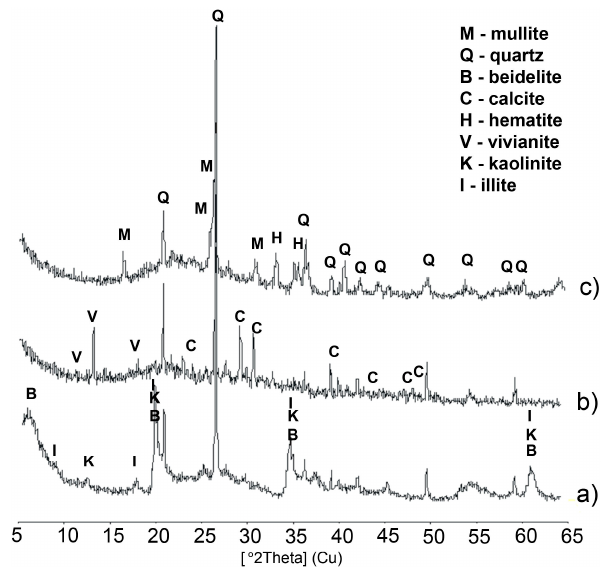
Figure 3. XRD patterns of: ( a ) Mszczonów clay; ( b ) sewage sludge; and ( c ) lightweight aggregates burnt at a temperature of 1150 °C.